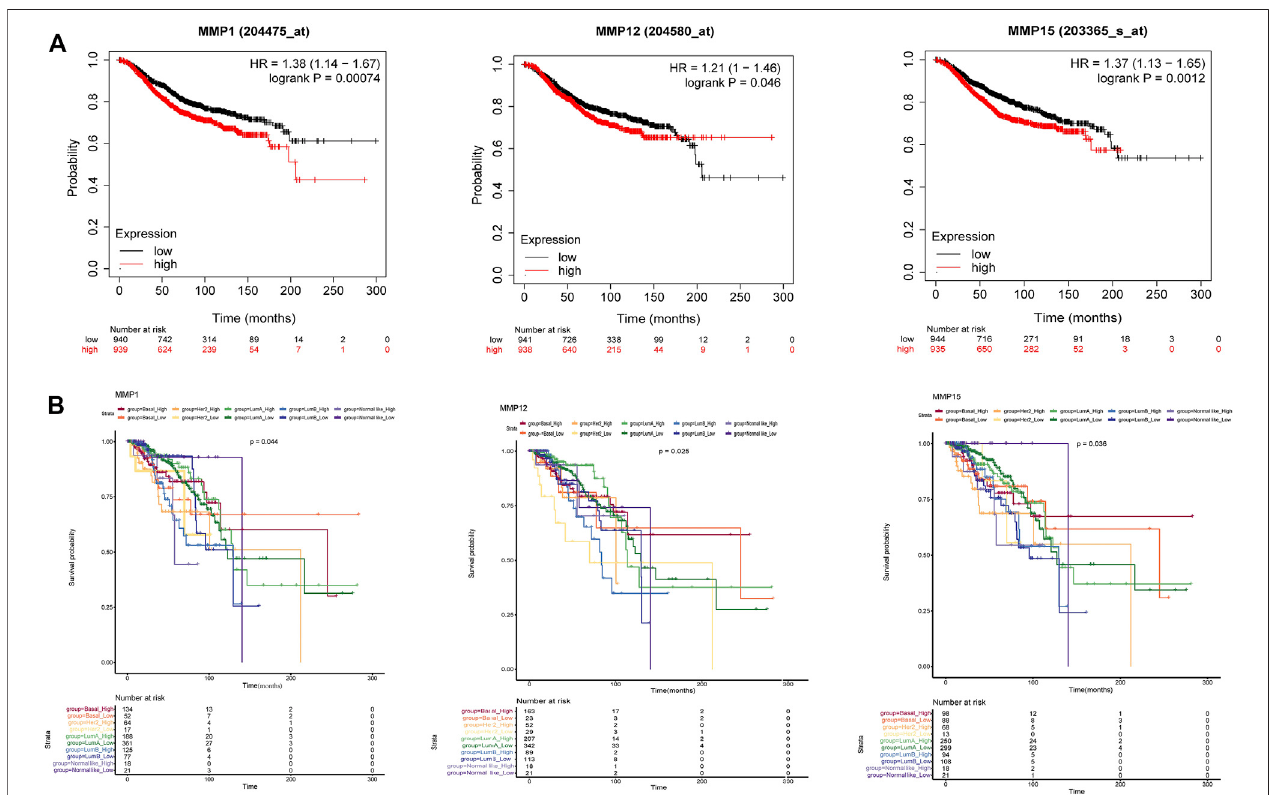
FIGURE 4 | (A) The overall survival of BRCA in MMP1, MMP12 and MMP15. High expression of MMP1, MMP12 and MMP15 was correlated with a poorer prognosis ( p < 0.05). (Kaplan-Meier Plotter) (B) The overall survival of fi ve BRCA subtypes in MMP1, MMP12 and MMP15 ( p <